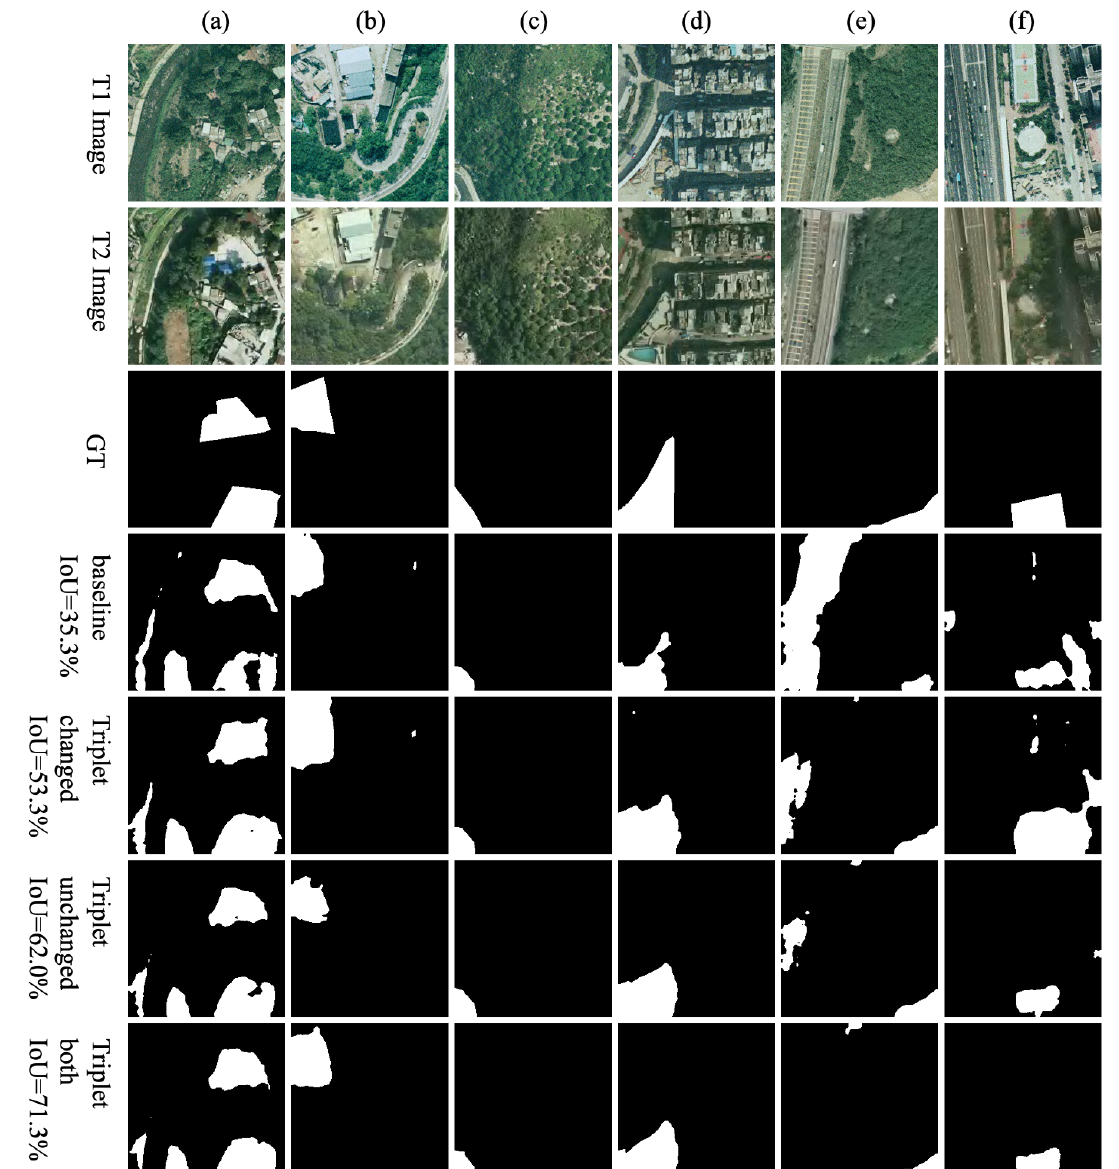
Figure 7. Comparison of different loss functions for binary change detection. We also list IoU values of each method over the sample images. Subfigures ( a – f ) are six samples from SYSU-CD